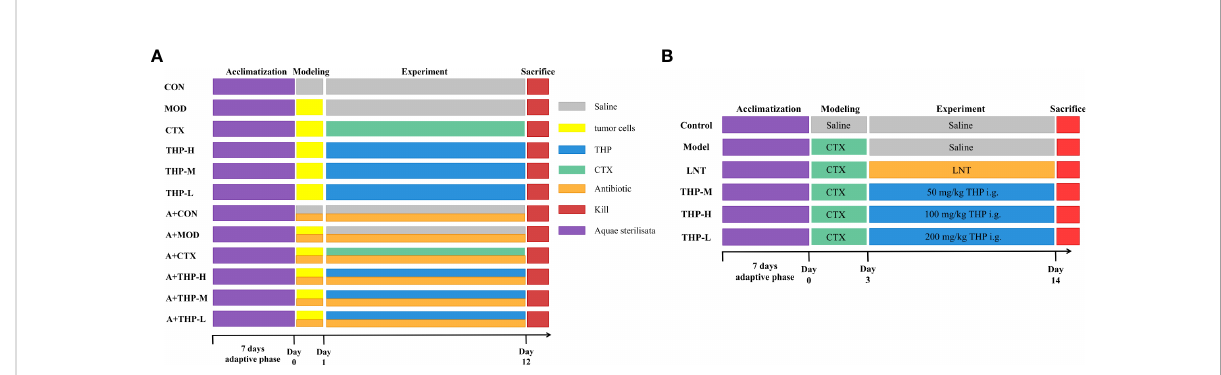
FIGURE 1 Grouping and administration of mice. (A) The antitumor lung cancer model animal experimental protocol. (B) The immunosuppression model animal experimental protocol. Control, normal control group; Model, model control group; LNT, Lentinan group; THP-L, THP low dose group (50 mg/kg); THP-M, THP medium dose group (100 mg/kg); THP-H, THP high dose group (200 mg/kg); CON, normal control group; MOD, tumor model control group; CTX, CTX group; THP-L, THP low dose group (50 mg/kg); THP-M,THP medium dose group (150 mg/kg); THP-H, THP high dose group (200 mg/kg); A+CON, antibiotic+normal control group; A+MOD, antibiotic+tumor model control group; A+CTX, antibiotic+CTX group; A+THP-L, antibiotic+THP low dose group (50 mg/kg); A+THP-M, antibiotic+THP medium dose group (150 mg/kg); A +THP-H, antibiotic+THP high dose group (200